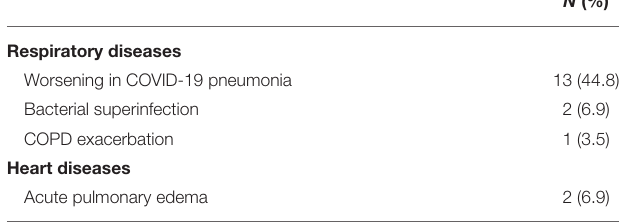
TABLE 3 | Misdiagnosis that led to diagnostic